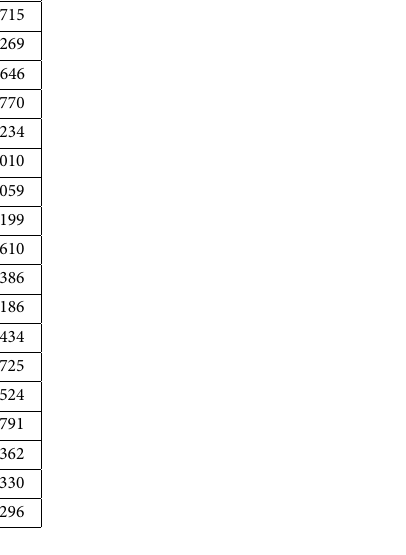
Table 4. Simulated MSE when p = 7 and intercept = −